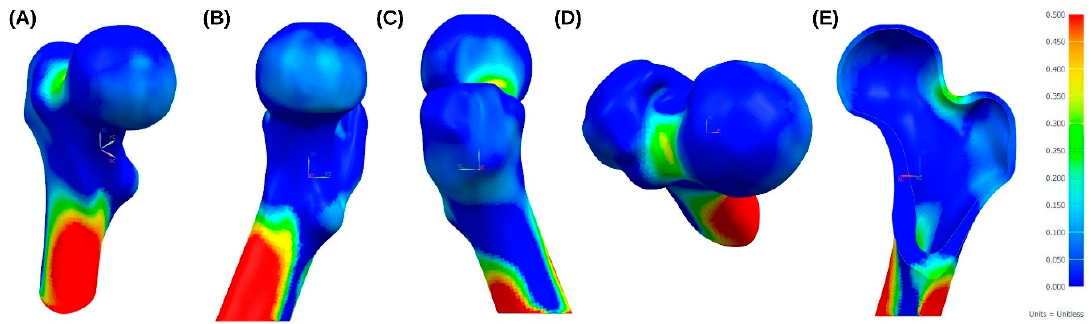
Figure 16. ( A ) Isometric, ( B ) right, ( C ) left, ( D ) top and ( E ) back view of Tsai–Wu field in proximal femur when applying sitting-down loads.